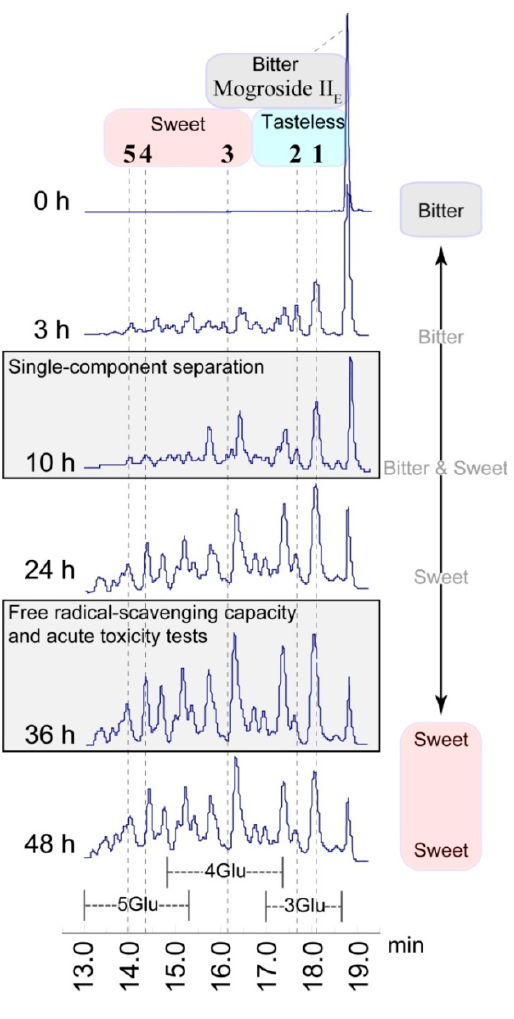
Figure 4. Product changes detected by